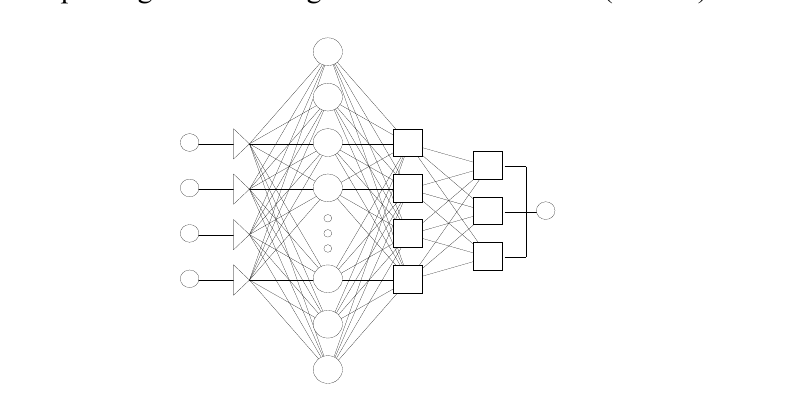
Figure 5. Example of generalized regression neural network (GRNN)